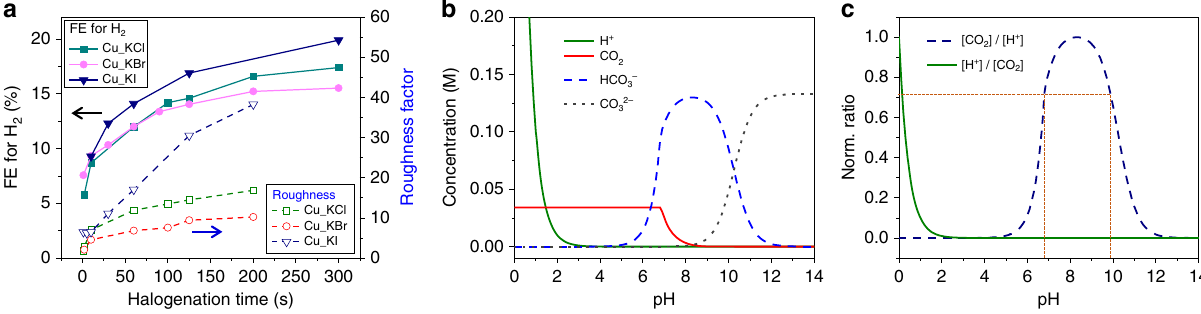
Fig. 7 Relation between surface roughness of the electrocatalysts and HER. a The roughness factor of the catalyst was estimated from the double-layer capacitance as measured by cyclic voltammetry (CV) in the potential range from − 0.35 to − 0.5 V vs. Ag/AgCl. FE for H 2 from Fig. 6. b Calculated concentrations of reactants and buffering ions in 0.1 M KHCO 3 saturated with CO 2 . c The normalized concentration ratio of dissolved CO 2 to proton as calculated from Fig. 7b. Source data are provided as a Source data fi